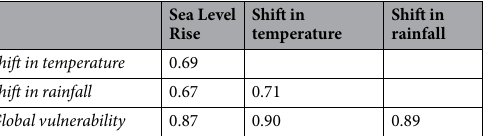
Table 1. Correlation coefficients between vulnerability scores for each threat across all islands using Pearson’s correlation test. All results were significant (p-value ≤ 2.2 * 10 − 16